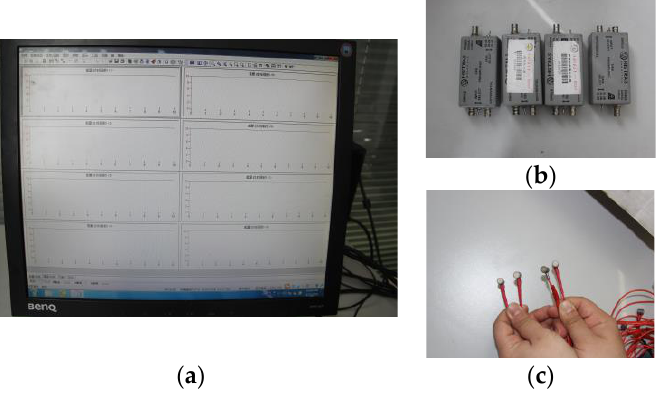
Figure 6. Acoustic emission system. ( a ) acoustic emission acquisition system; ( b ) amplifier; ( c ) sen- sor.